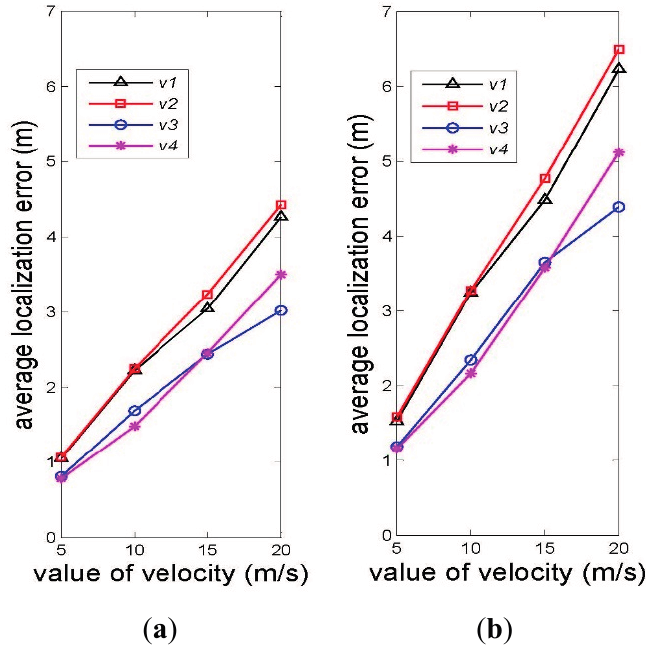
Figure 10. Average localization error vs. value of velocity: ( a ) scenario 1 and ( b ) scenario